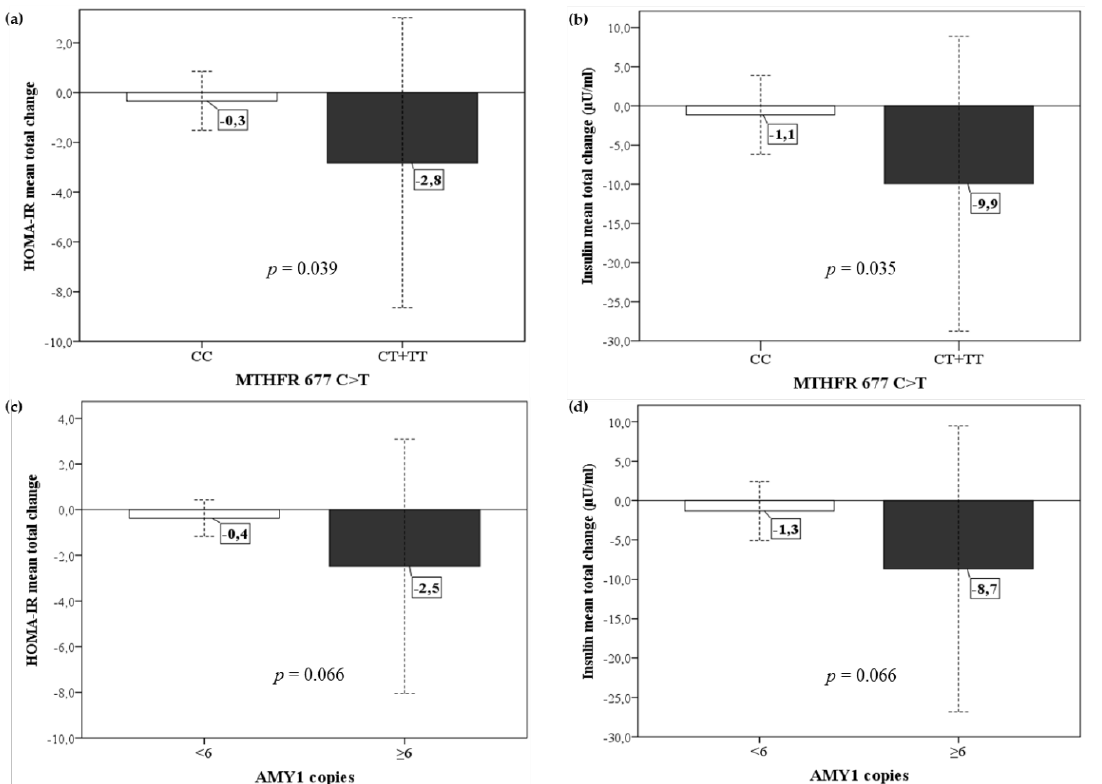
Figure 2. Mean changes in HOMA-IR and insulin after dietary intervention in relation to the DRAG polymorphisms in MTHFR and AMY1 . a) Comparison of mean total HOMA-IR change between MTHFR CC vs. CT+TT carriers. b) Comparison of mean total insulin change between MTHFR CC vs. CT+TT carriers. c) Comparison of mean total HOMA-IR change between subjects with < 6 vs. ≥ 6 copies of AMY1 . d) Comparison of mean total insulin change between subjects with < 6 vs. ≥ 6 copies of AMY1 . Values are the mean ± standard deviation of the total changes (baseline vs. 24-weeks). p - values of the Mann–Whitney U test are reported.